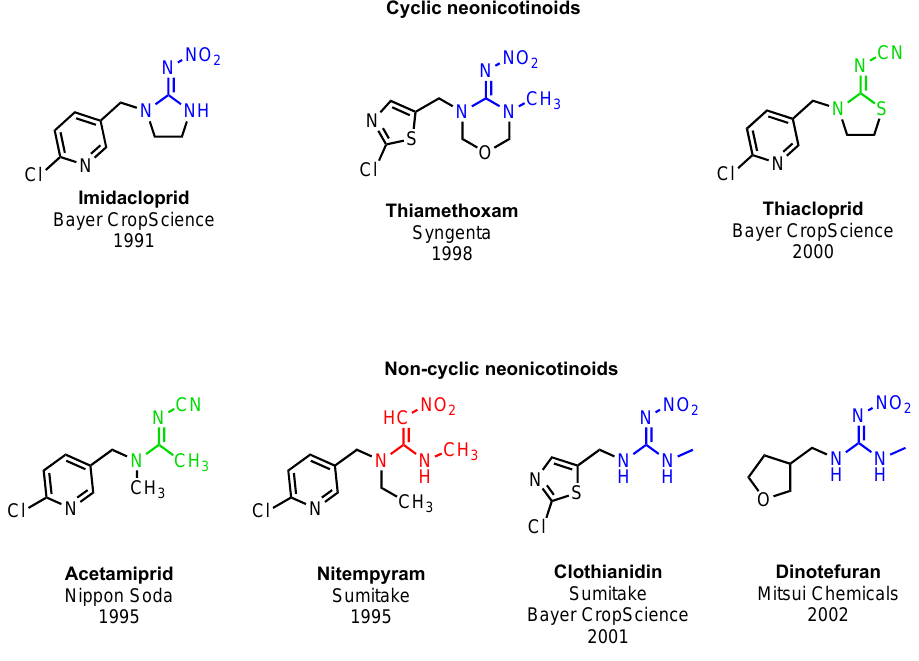
Figure 1. Neonicotinoids. Figure 1.